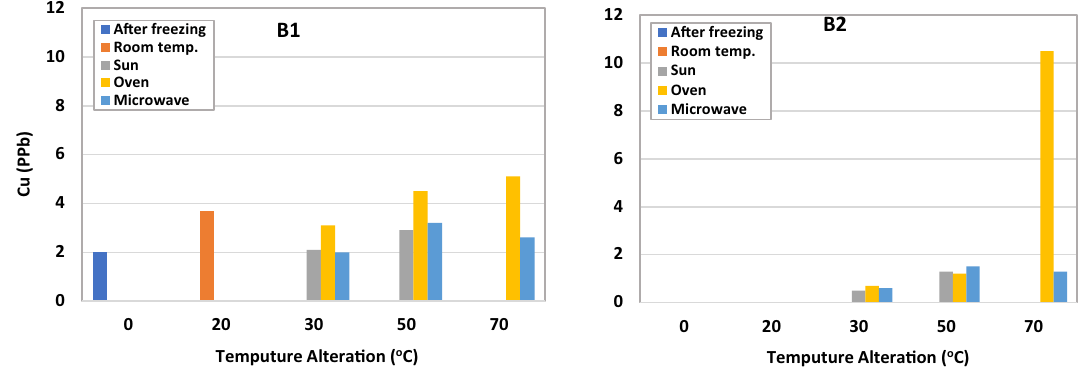
Fig. 8 Copper concentrations at different heating degrees for brands B1 and